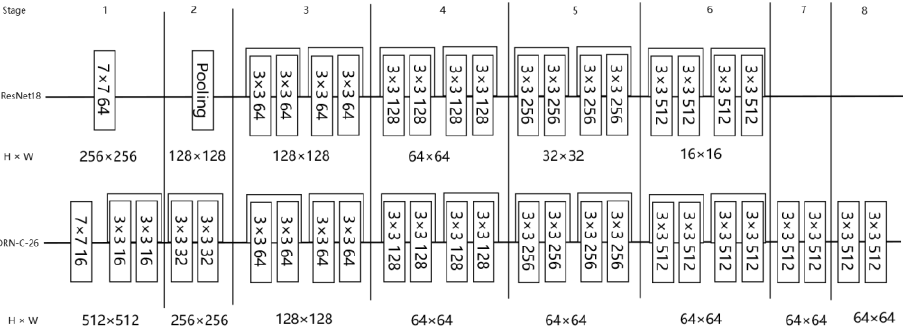
Figure 1. A comparison of ResNet18 and DRN-C-26. Each rectangle in the figure represents a Conv- BN-ReLU combination. The number in the rectangle indicates the size of the convolution kernel and the number of output channels. H × W indicates the height and width of the feature map.